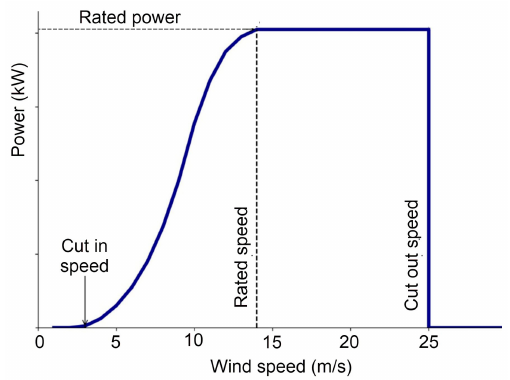
Figure 5. Typical wind turbine power